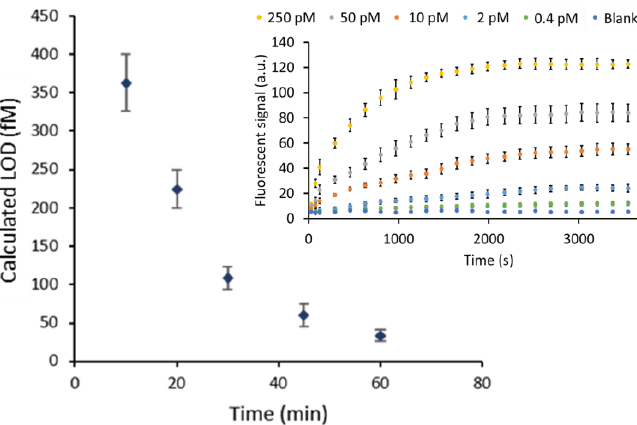
Figure 3. The calculated LOD values (fM) obtained for varying HCR polymerization times. The error bars represent the estimated LOD range. Insert: HCR reaction over time for different HAB target concentrations (250, 50, 10, 2, 0.4 pM and a blank). The error bars represent the standard deviation of three repetitions. The SNR ratios that were mentioned in the text are based on the highest concentration of HAB target that is indicated by the yellow labels. A high resolution version of the inset can be found in supporting Figure S1.